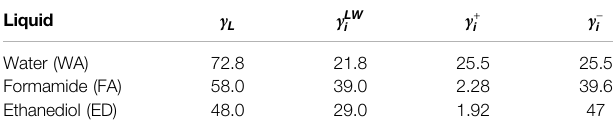
The surface tension values of liquids are taken from Sawisai et al. (2019 and van Oss (1993).